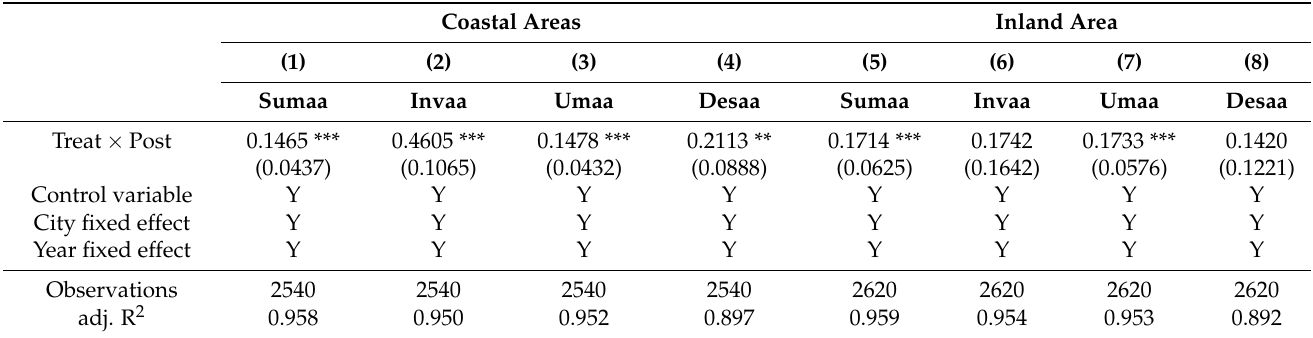
Table 9. Regression results of urban geographical